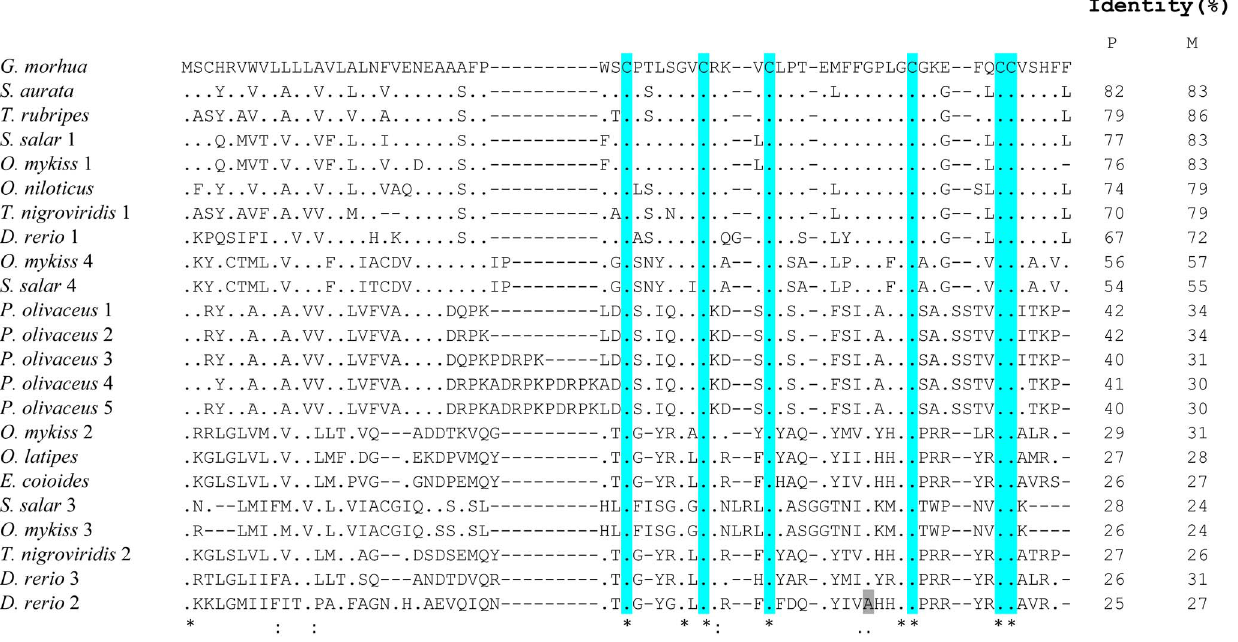
Figure 2. Multiple alignment of cod beta-defensin amino acid sequences with other beta-defensin proteins from teleosts. Identical amino acid to cod beta-defensin are represented by dots, while identity, similarity and weak similarity residues across fish taxa are represented by (), (:) and ( ? ), respectively. The six conservative cysteine residues are shaded in blue. Identity between cod beta-defensin of various beta-defensin peptide precursors (P) or mature peptides (M) are also shown on the right. Accession number of the sequences are listed on Table 2.